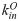
The segregation process depends on organelle size and flux rate.The mean PDMT is plotted over time. Organelle max radius b: 140 nm for blue and green curves (same as Fig 4); b = 70 nm for red and cyan curves. Organelle flux rate kinO: same as Fig 4 (x1; blue and red), 1.5-fold greater (x1.5; green) and 2-fold greater (x2; cyan). Each curve represents an average of 5 realizations of the model and the error bars are the standard deviation. All other parameters are the same as in Fig 4.